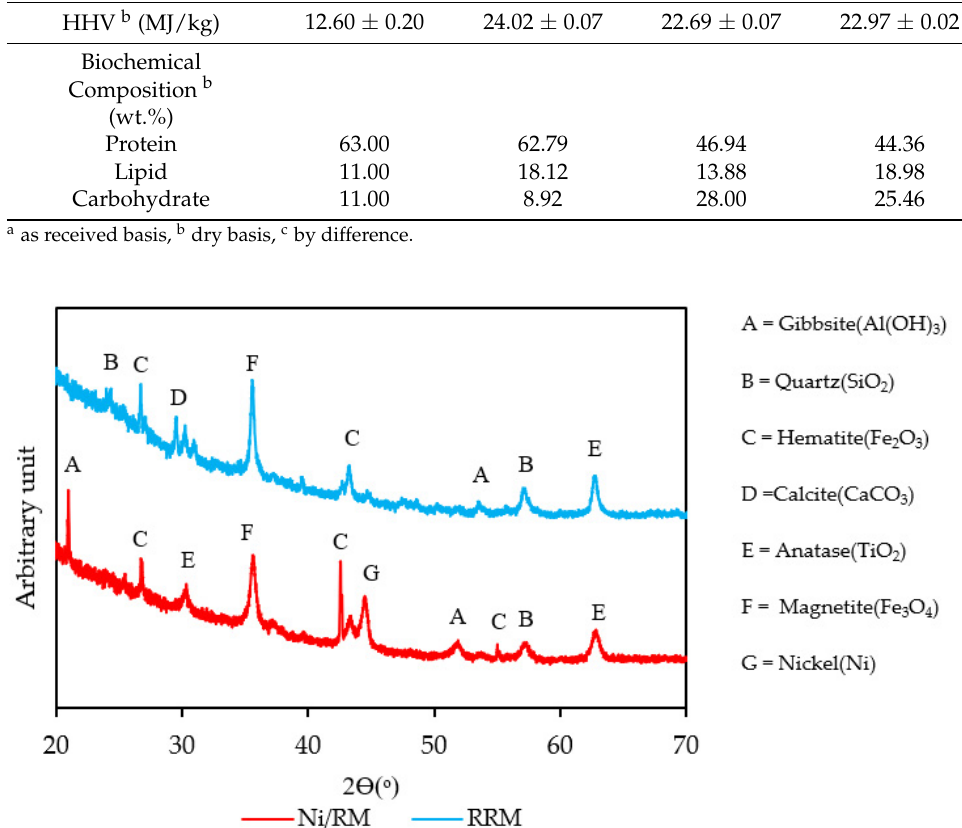
Figure 1. XRD pattern of RRM and Ni/RM catalysts.